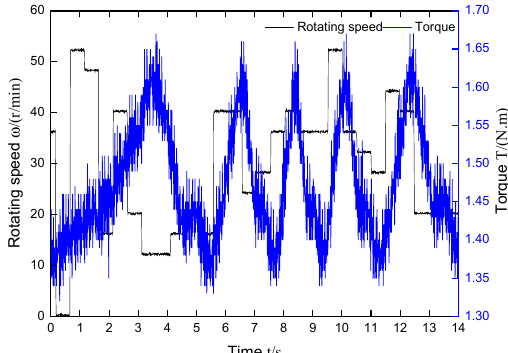
Figure 10. The change process of torque and rotating speed in Case